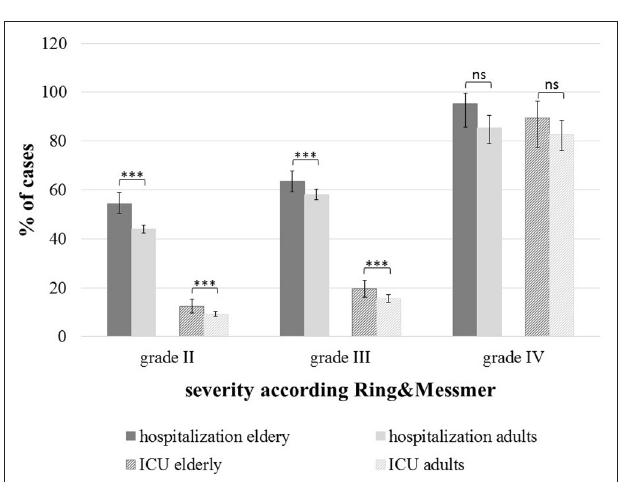
FIGURE 4 | Hospitalization and intensive care unit admissions across the severity grades according to Ring & Messmer; elderly ( n = 1,123) and adults ( n = 5,768); *** p < 0.001, ns, not